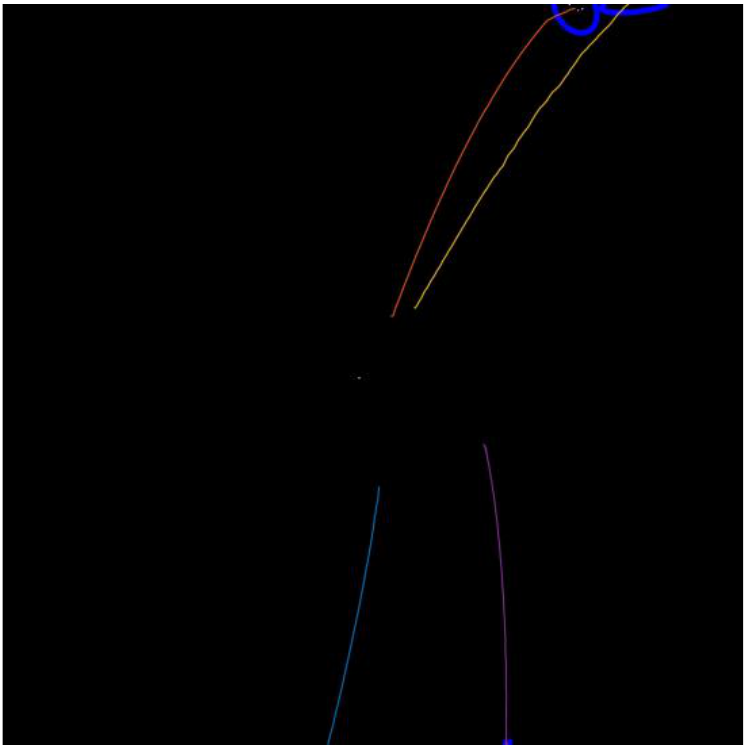
Figure 7. True trajectories of the targets. The orange line denotes the trajectory of the first target. The yellow line denotes the trajectory of the second target. The blue line denotes the trajectory of the third target. The purple line denotes the trajectory of the fourth target. Table 3. The initial states of the